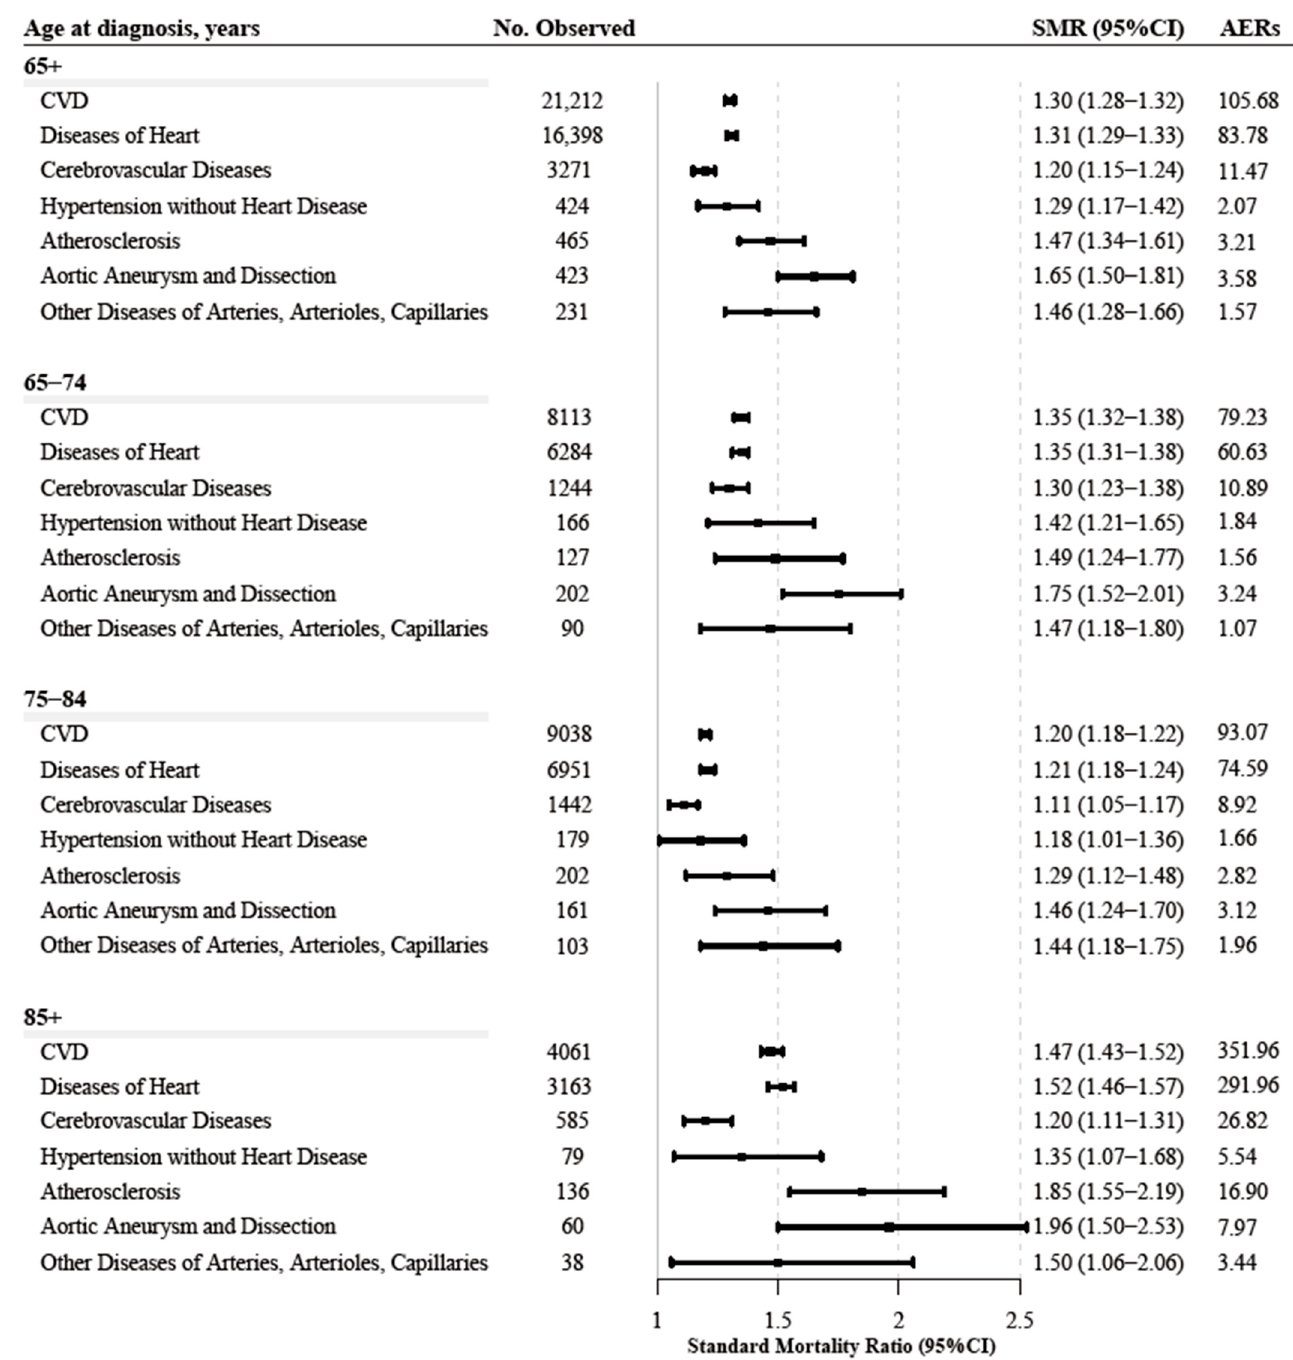
Figure 3. The risk of cardiovascular death among older patients ( ≥ 65 years) with bladder cancer. In individualized subgroups, the risks of CVD-related death, heart disease, and cer- ebrovascular disease were also higher in BC patients aged >65 years compared to the gen- eral population (Figure 4). The other four outcomes (atherosclerosis, aortic aneurysm and dissection, hypertension without heart disease, and other diseases of the arteries, arteri- oles, and capillaries) showed similar trends (Supplementary Figures S10–S13).